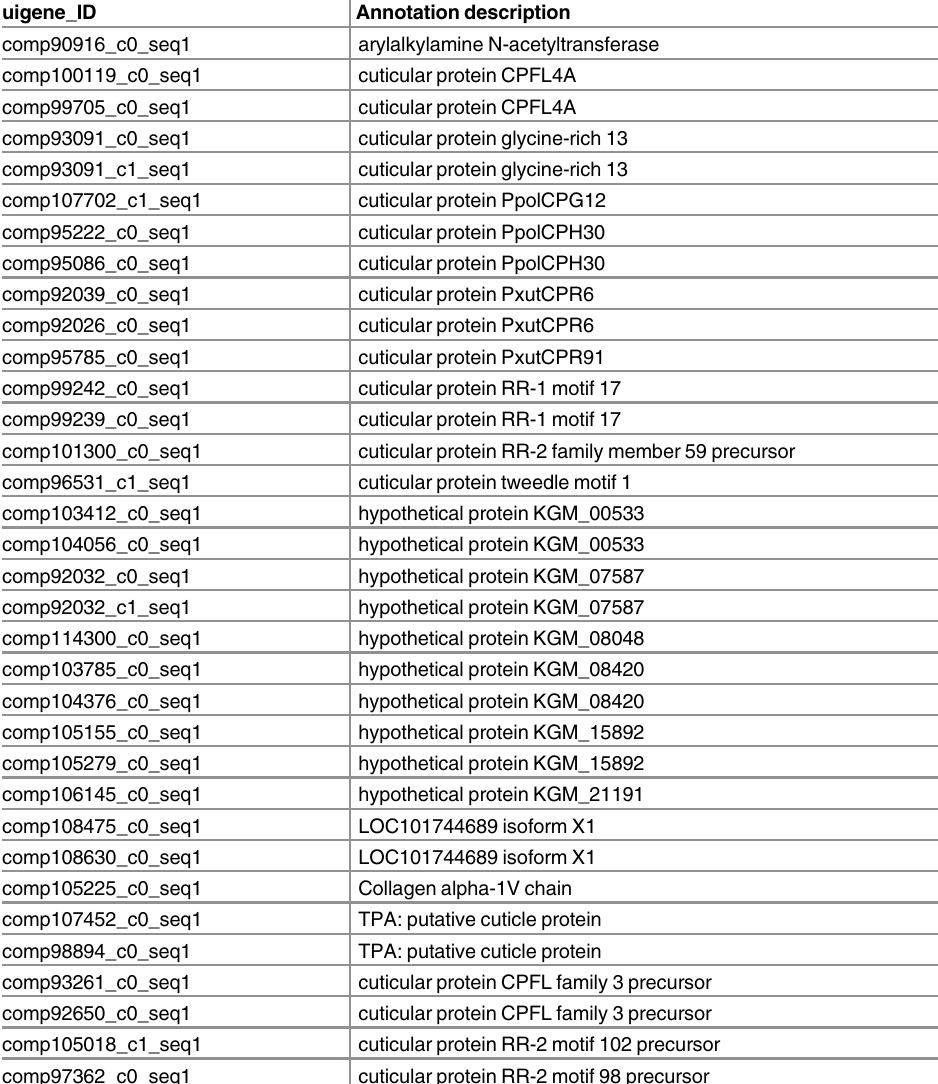
Table 4. Differential expression genes at all pairwise adjacent developmental